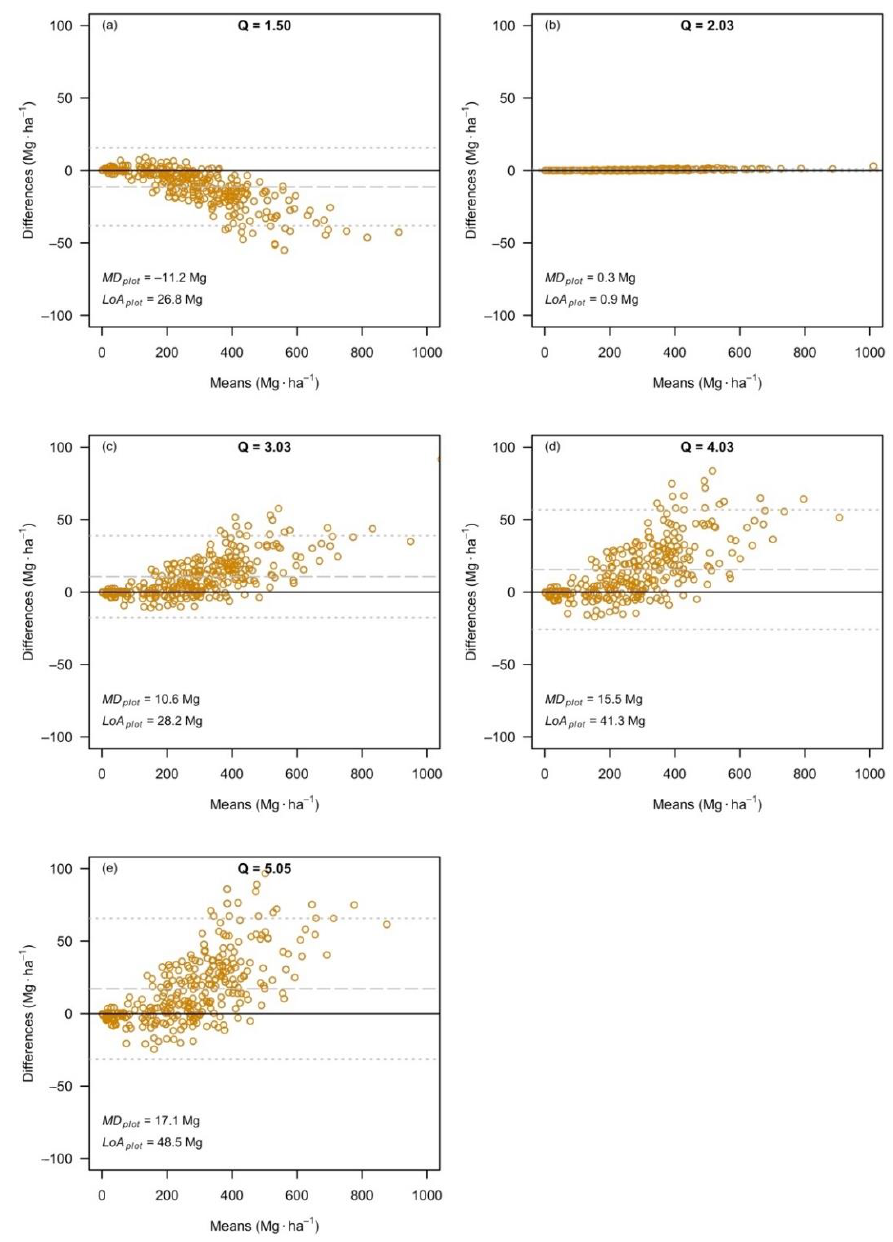
Figure 2. The Bland–Altman plots, comparing the individual plot estimates, that resulted from individual tree predictions based on separate variable models and combined variable models, based on Dataset Q1 ( a ), Dataset Q2 ( b ), Dataset Q3 ( c ), Dataset Q4 ( d ) and Dataset Q5 ( e ). Note: the dashed grey line represents the mean difference ( MD plot ), and dotted grey lines show the limits of agreement ( LoA plot ).